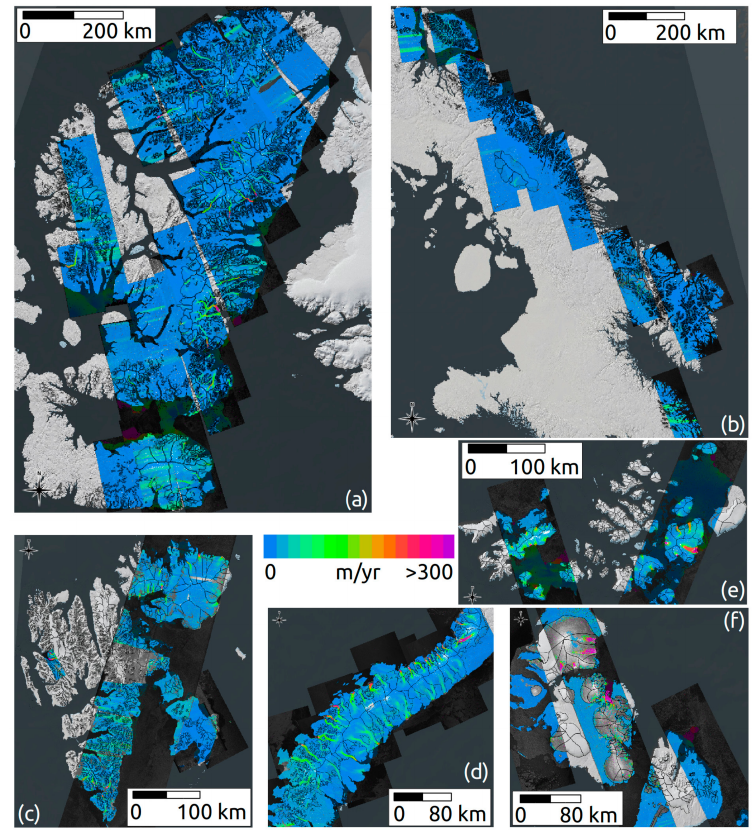
Figure 2. Ice velocity maps for ( a ) the Canadian Arctic North from ALOS-1 PALSAR-1 data of 2007 to 2011; ( b ) the Canadian Arctic South from ALOS-1 PALSAR-1 data of 2007 to 2011; ( c ) the Svalbard Archipelago from JERS-1 SAR data of 1994 to 1998 complemented by ALOS-1 PALSAR-1 data of 2010–2011 to the east and TerraSAR-X data of 2008 to the west; ( d ) Novaya Zemlya from ALOS-1 PALSAR-1 data of 2008 to 2009; ( e ) Franz-Josef Land from JERS-1 SAR data of 1998 in the east and ALOS-1 PALSAR-2 data of 2010 in the west; and ( f ) Severnaya Zemlya from ALOS-1 PALSAR-1 data of 2010. Details on the acquisition dates and time intervals of the satellite SAR data are listed in the Supplementary Table